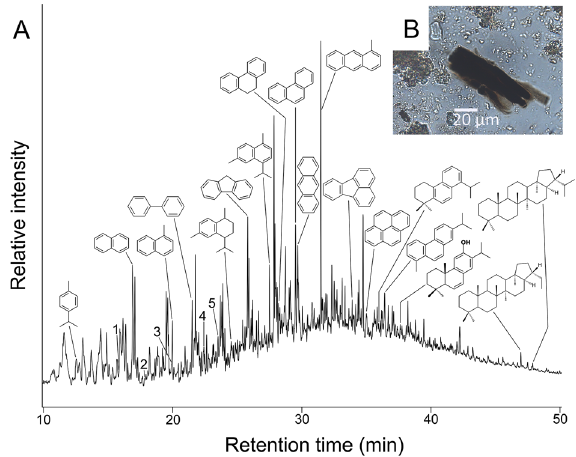
Figure 2. ( A ) Reconstructed total ion chromatogram of the thermal desorption profile (310 °C for 5 min, 610 °C for 10 s (see Materials and Methods)) of human dental calculus from TIR002.B. Peak identities: the lignite/coal markers numbered 1–5 were identified as: 1 = succinimide, 2 = benzoic acid, 3 = benzamide, 4 = phthalic anhydride, 5 = phthalimide. Also shown are the structures of eight polynuclear aromatic hydrocarbons (combustion markers): naphthalene, 1-methylnaphthalene, biphenyl, fluorene, 9,10-dihydrophenanthrene, phenanthrene, anthracene, 1-methyl anthracene, fluoranthene and pyrene. In addition, the structures of the terpenoids characteristic of Cupressaceae deriving from the lignite are shown, i.e. the main monoterpenoid compound identified: p-cymene, the main sesquiterpenoid compounds identified: calamenene and cadalene, and the main diterpenoid compounds identified: diaromatic totarane, retene and 6-dehydroferruginol. The main lignite-derived hopanes, 17α(H),21β(H)-norhopane and 17α(H),21β(H)-hopane are also shown. ( B ) Charcoal particle from TIR002.B (unknown